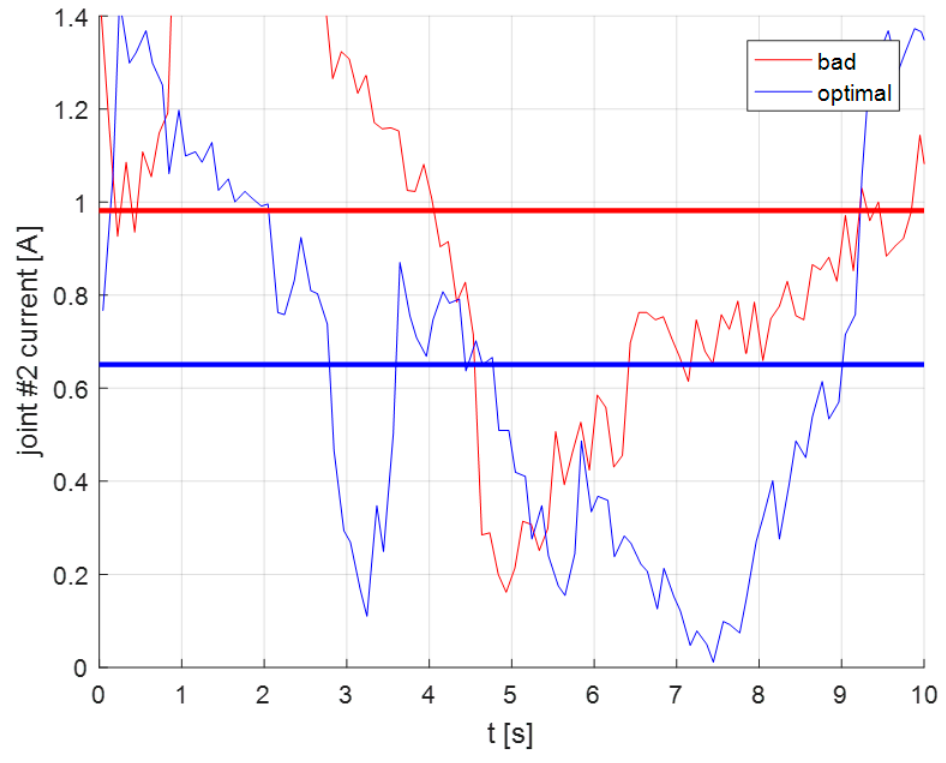
Figure 9. Current utilization and mean current during task execution in both locations for joint 2.